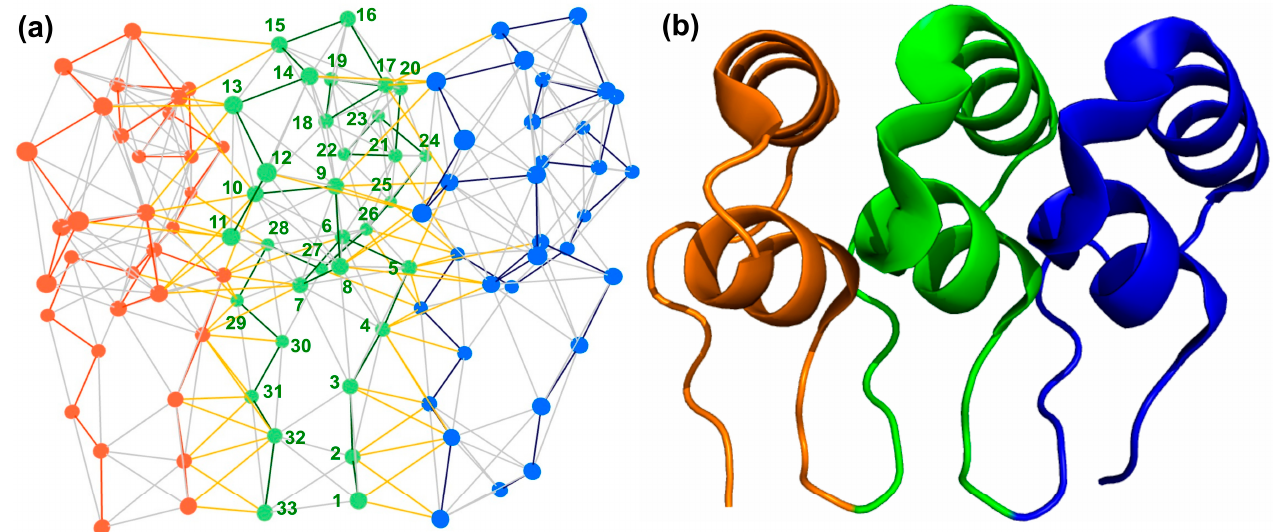
Figure 6. ( a ) Three-dimensional network view showing the intra-repeat edges in grey and inter-repeat edges in yellow for 3 copies of ankyrin repeat. The nodes and the backbone edges for the three copies are shown in blue, green, and orange color, respectively. The residue positions in the intermediate copy (green) are marked. ( b ) The 3D structure view of the 3 copies is shown in the same orientation as shown in the network view.